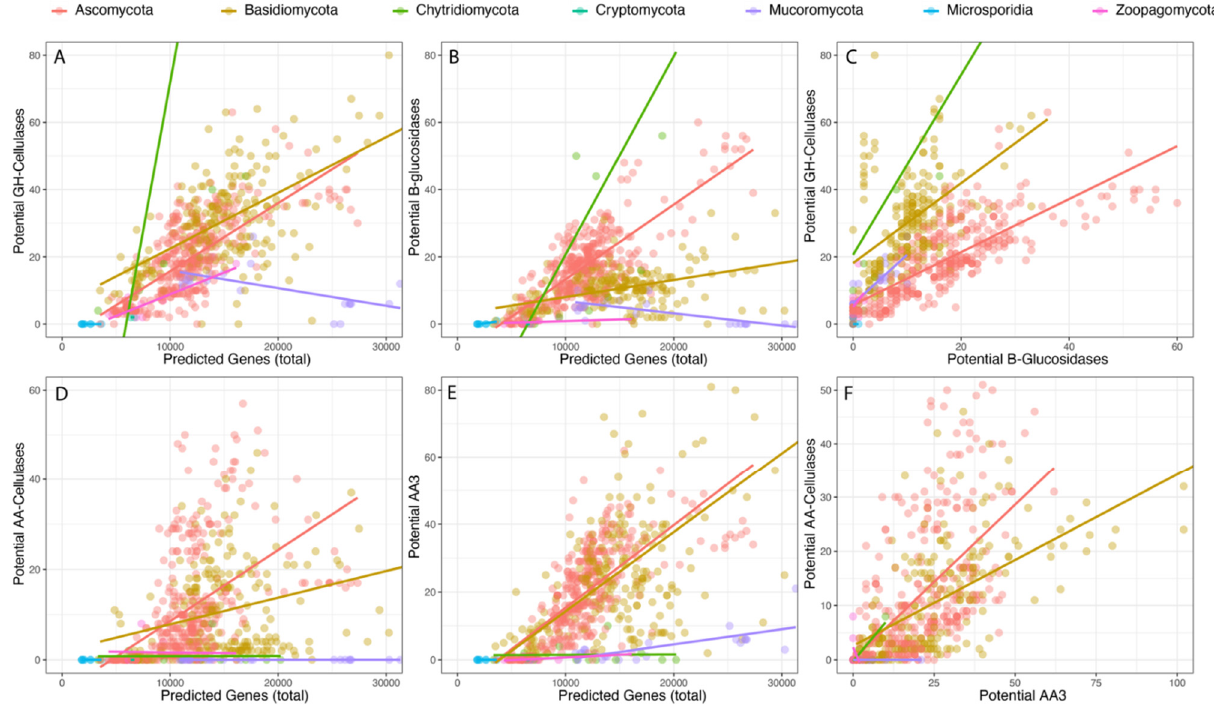
Figure 1. The total number of predicted genes encoding potential GH-cellulases (A), β -glucosidases (B), AA-cellulases (D) , and AA3 (E) enzymes across sequenced fungal genomes and the relation between the number of cellulolytic enzymes (GH-cellulases and AA-cellulases) and the number of enzymes active on cellobiose (C and F). Lines depict the linear regression between the number of predicted genes encoding the potential enzymes and the predicted total number of genes.